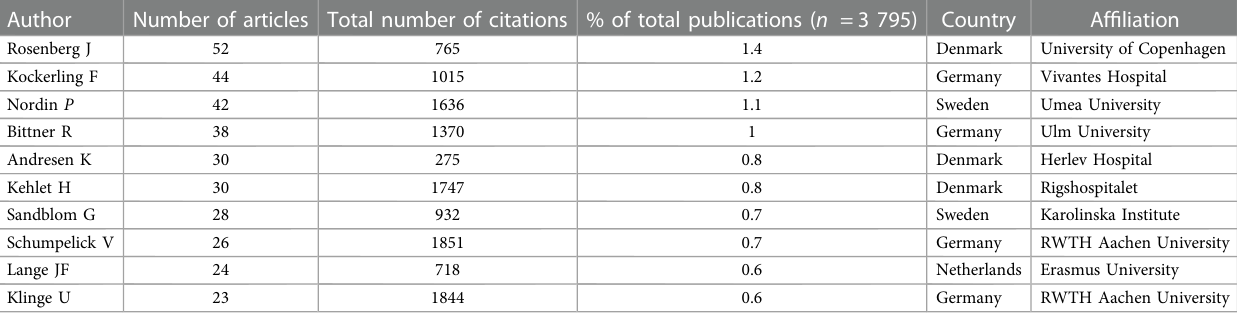
TABLE 3 The ten authors with the highest production of articles on inguinal hernia in the Web of science.